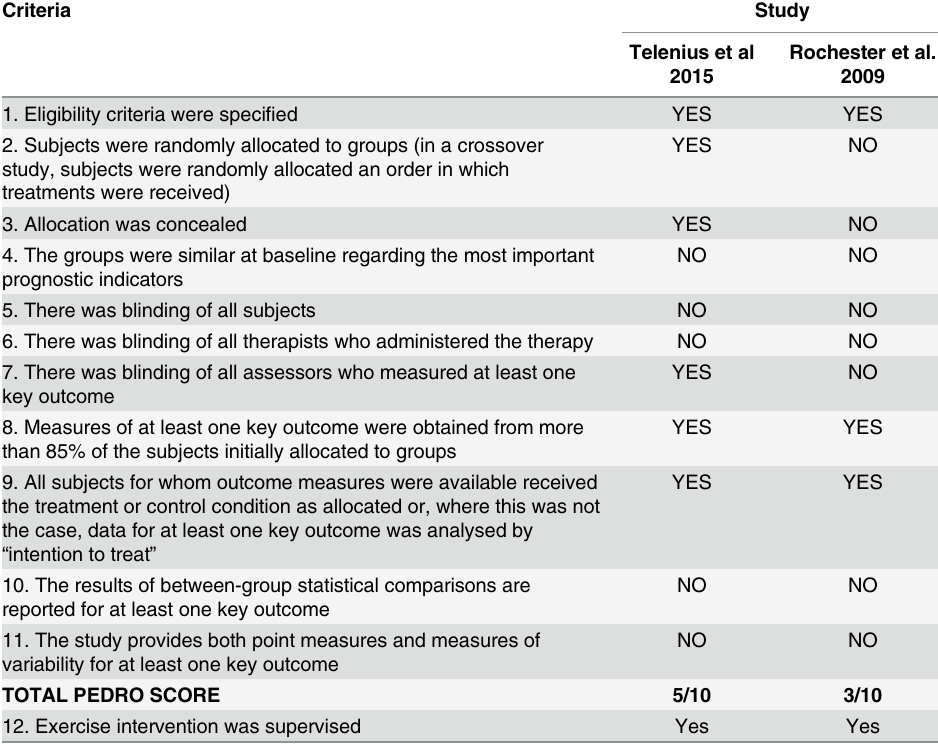
Table 1. PEDro score: Experimental studies.